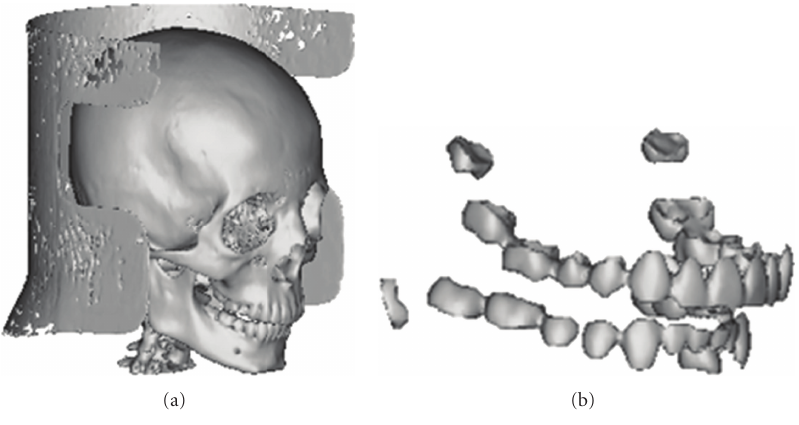
Figure 6: The surface models created through the polygon/facet creation process.